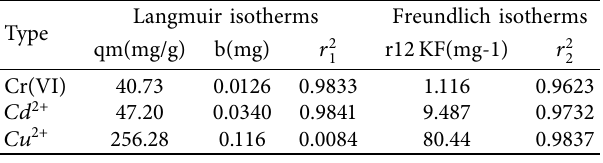
Table 3: Adsorption isotherm model parameters of composites for different heavy metal